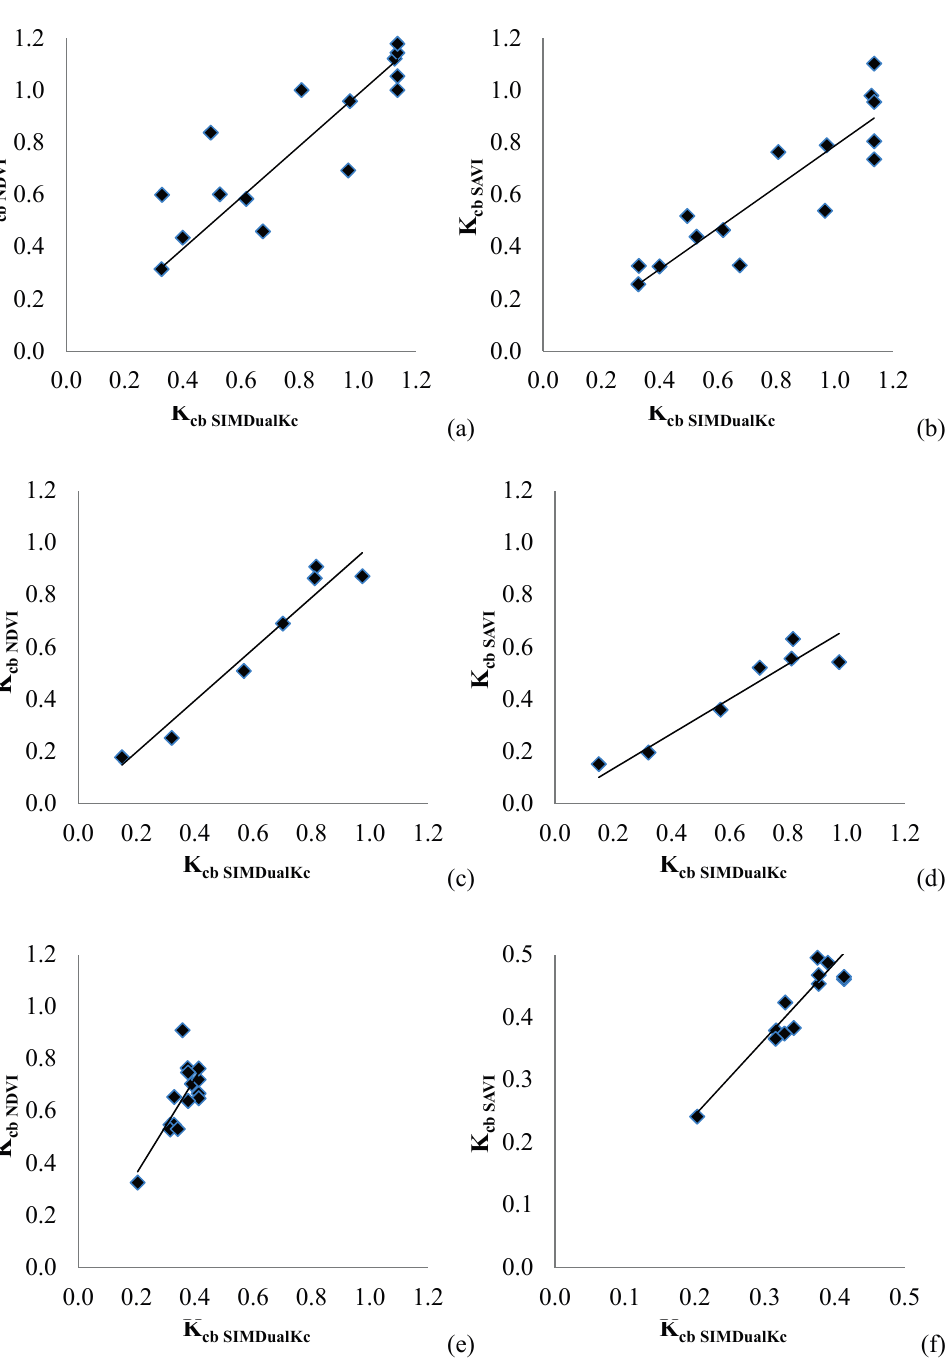
Figure 4. Comparison of actual K cb derived from NDVI (K cb NDVI ), on left, or from SAVI (K cb SAVI ), on right, with the actual K cb obtained with SIMDualKc (K cb SIMDualKc ) for maize ( a , b ), barley ( c , d ) and the olive crop ( e , f